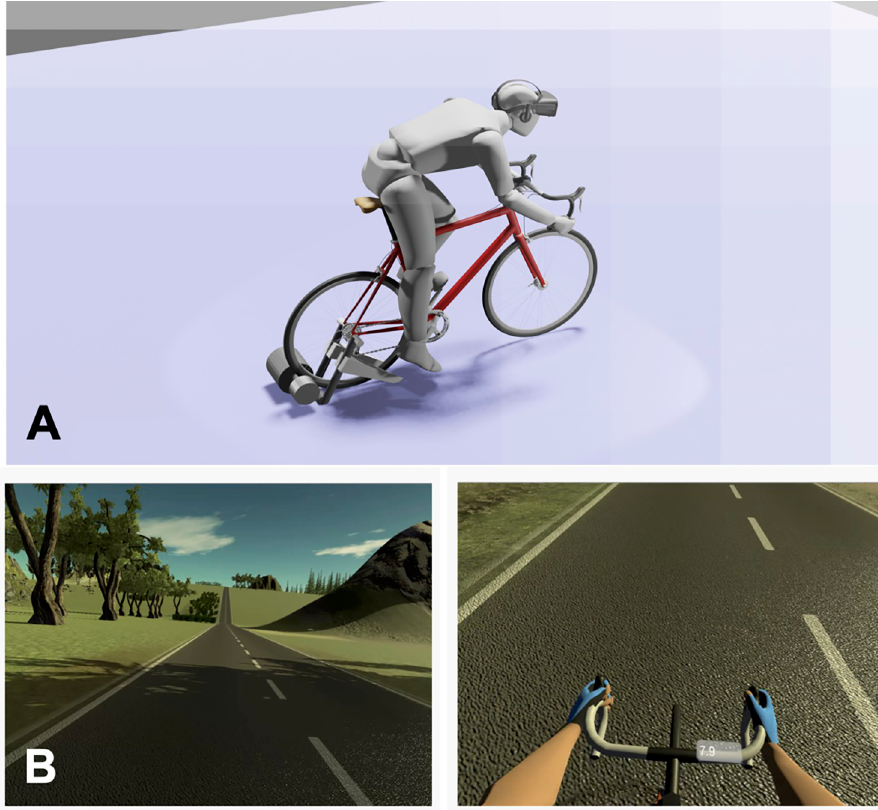
Fig 1. A. Image of the bicycle ergometer set-up and B. (top) the VR environment (bottom) virtual hands and